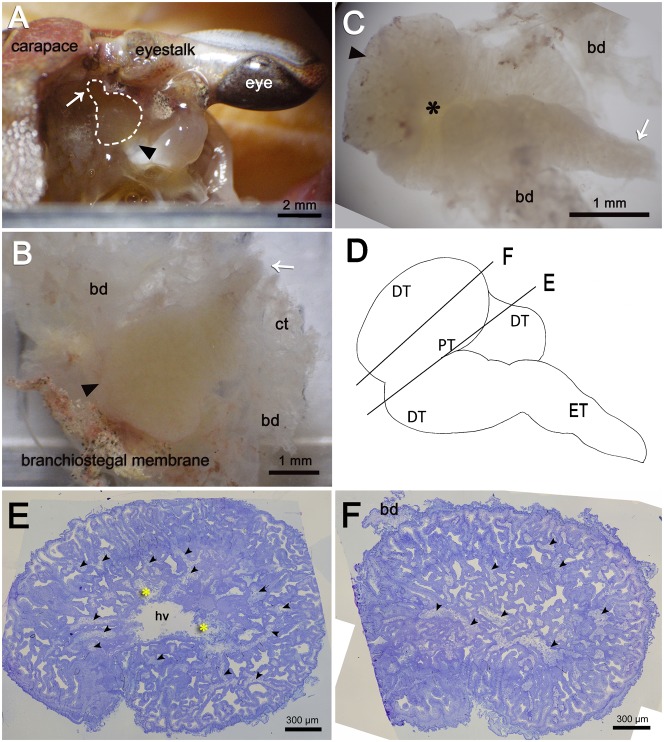
The gross anatomy and the portions of the antennal gland.(A) The antennal gland is located in the base of the eyestalk (as the dash circle shows). The arrowhead (◂) indicates the anterior portion of the antennal gland, and the arrow (←) indicates the posterior portion. (The dorsal view of the crab with the carapace removed. The upper side of this figure is the front of the crab.) (B,C) The removed antennal gland is coiled with the bladder (bd) and connective tissue (ct). (B) The dorsal view of the antennal gland has a smooth surface. (C) The ventral view of the antennal gland has an indentation (*) in the centre of the anterior portion. (D) The anterior portion of the antennal gland is composed of the proximal tubular region (PT) and the distal tubular region (DT). The posterior portion of the antennal gland is composed of the end tubular region (ET). Lines E and F represent the different sectioning levels of the antennal gland. In section (E), the sectioning level is crossing through the anterior part and includes both PT and DT. Tubular cells and large coelomosac (arrowheads) are found in the peripheral of the antennal gland defined as DT. A large haemolymph vessel (hv) is found in the centre of the antennal gland which is defined as PT. The haemocytes (*) are found in the haemolymph vessel (hv). In section (F), the sectioning level is on the peripheral region of the antennal gland and includes only DT. Numerous tubular cells and large coelomosac (arrowheads) filled up this region. Scale bars: 2 mm (A), 1 mm (B,C), 300 µm (E,F).